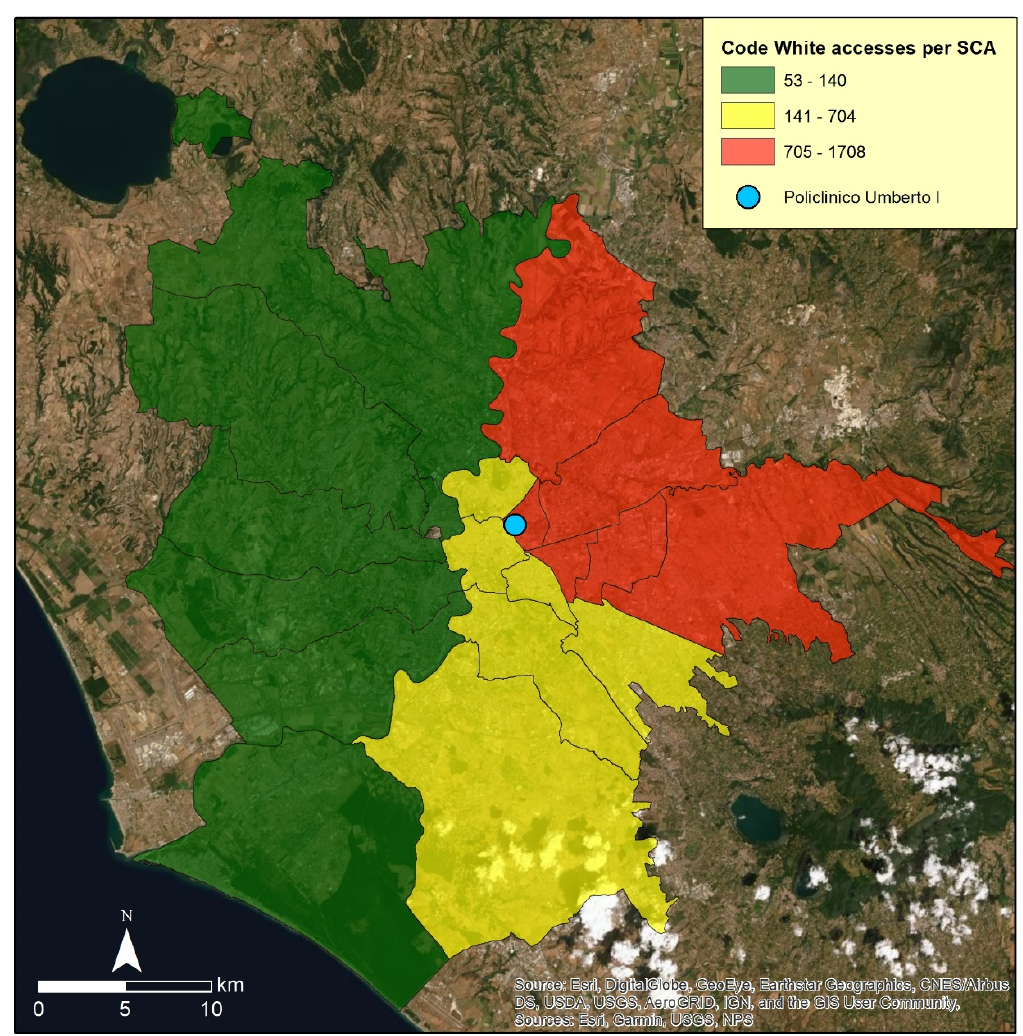
Figure 5. Accesses in code white recorded by the Policlinico Umberto I emergency room with data aggregated on the basis of sub-municipal areas. Source: authors’ elaboration.